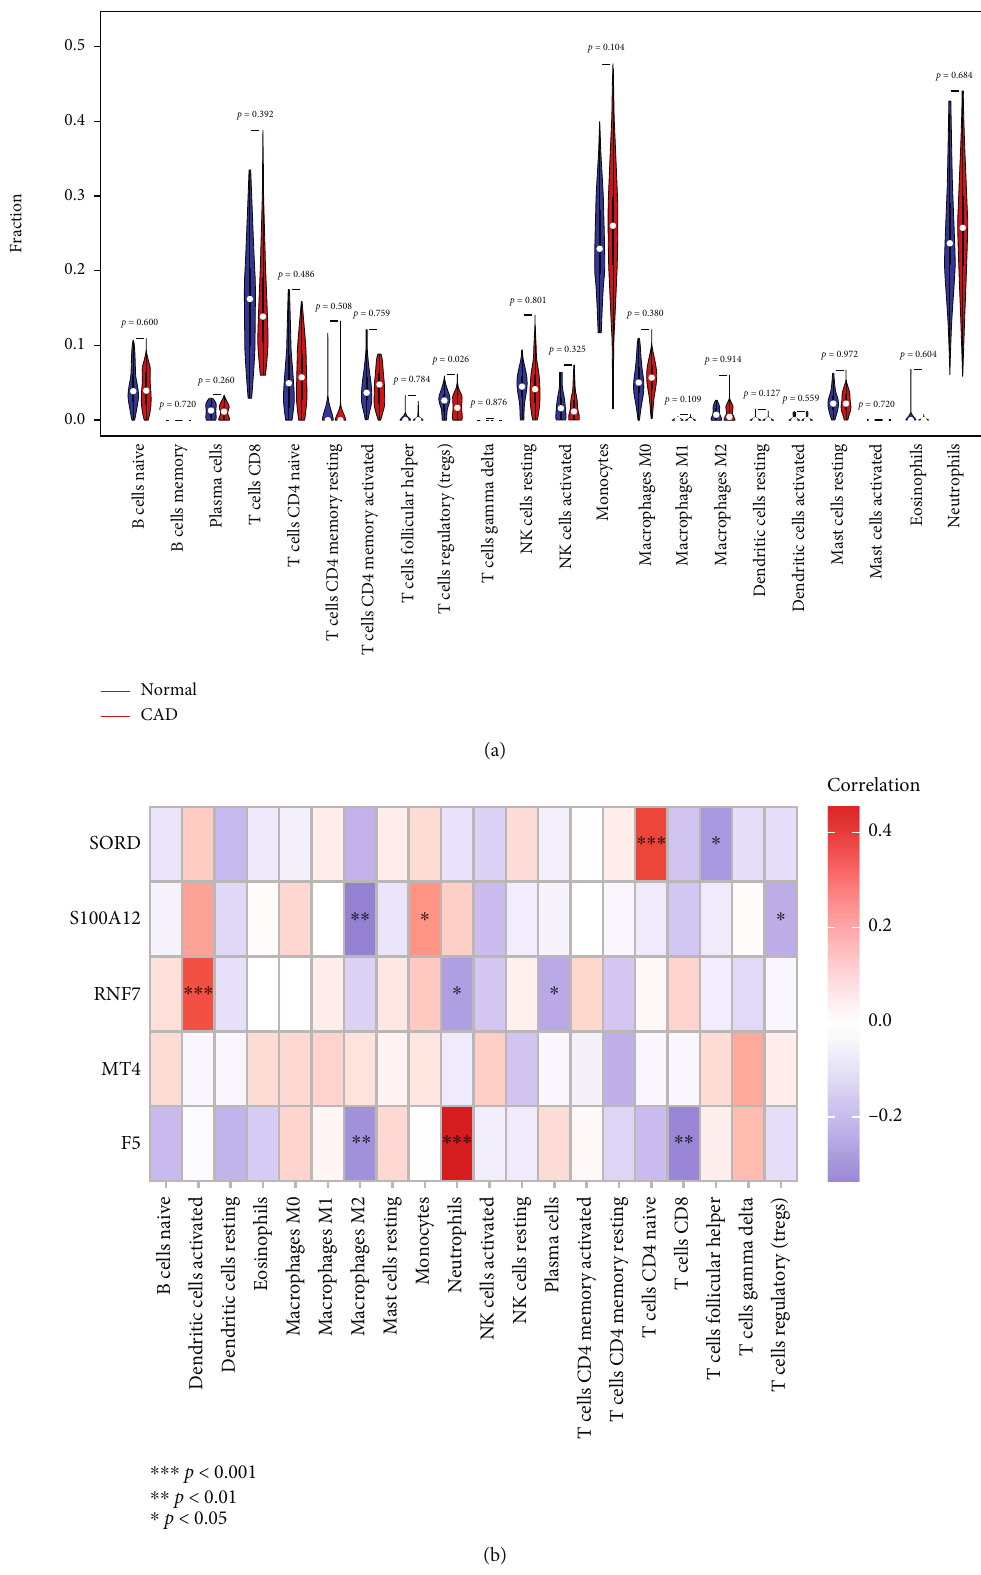
Figure 5: Immune microenvironment analysis. (a) By the Wilcoxon rank sum test, a di ff erential analysis of immune cell contents between CAD samples (red) and normal samples (blue) was conducted, and the results were shown in a violin diagram. (b) Correlation heat map of Spearman ’ s correlation analysis between 22 immune cells and marker